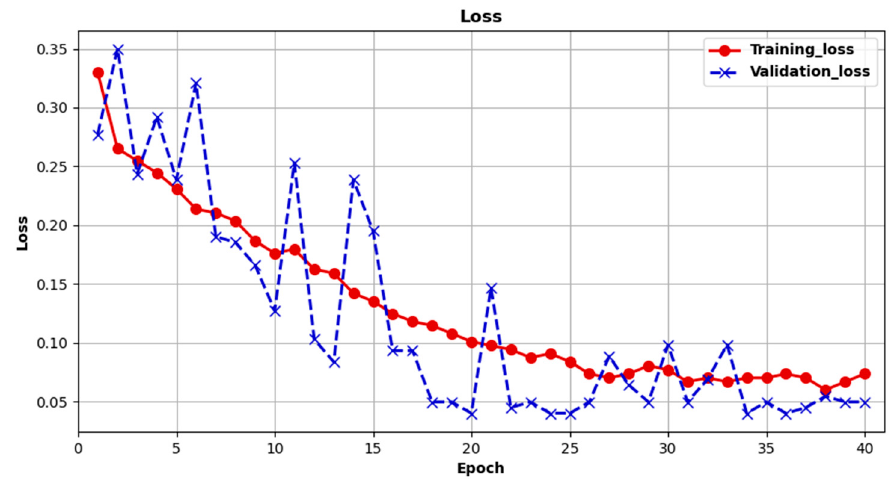
Figure 8. Convergence curves of the loss function.